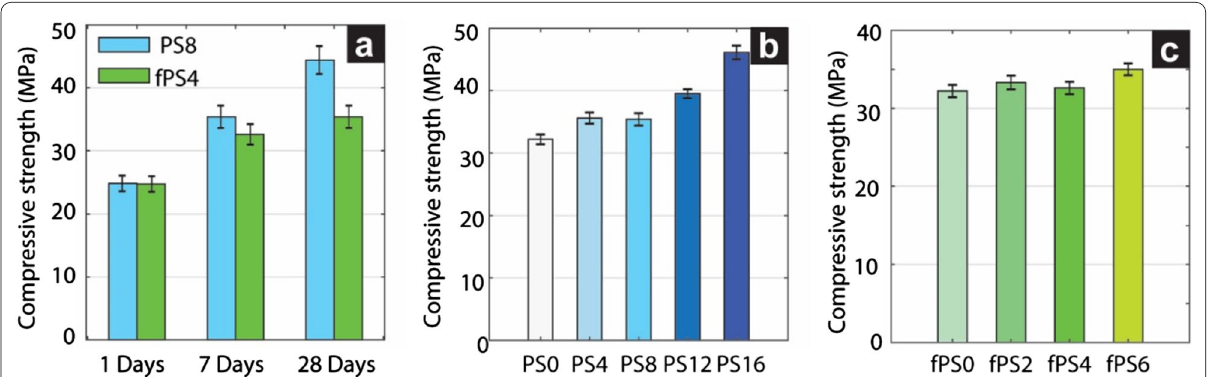
Fig. 6 a Compressive strength of PS8 and fPS4 at different curing ages and b , c compressive strength of MPC mortar with 1.6% hybrid fibres and 1.6% PP fibres, respectively, after curing for 7